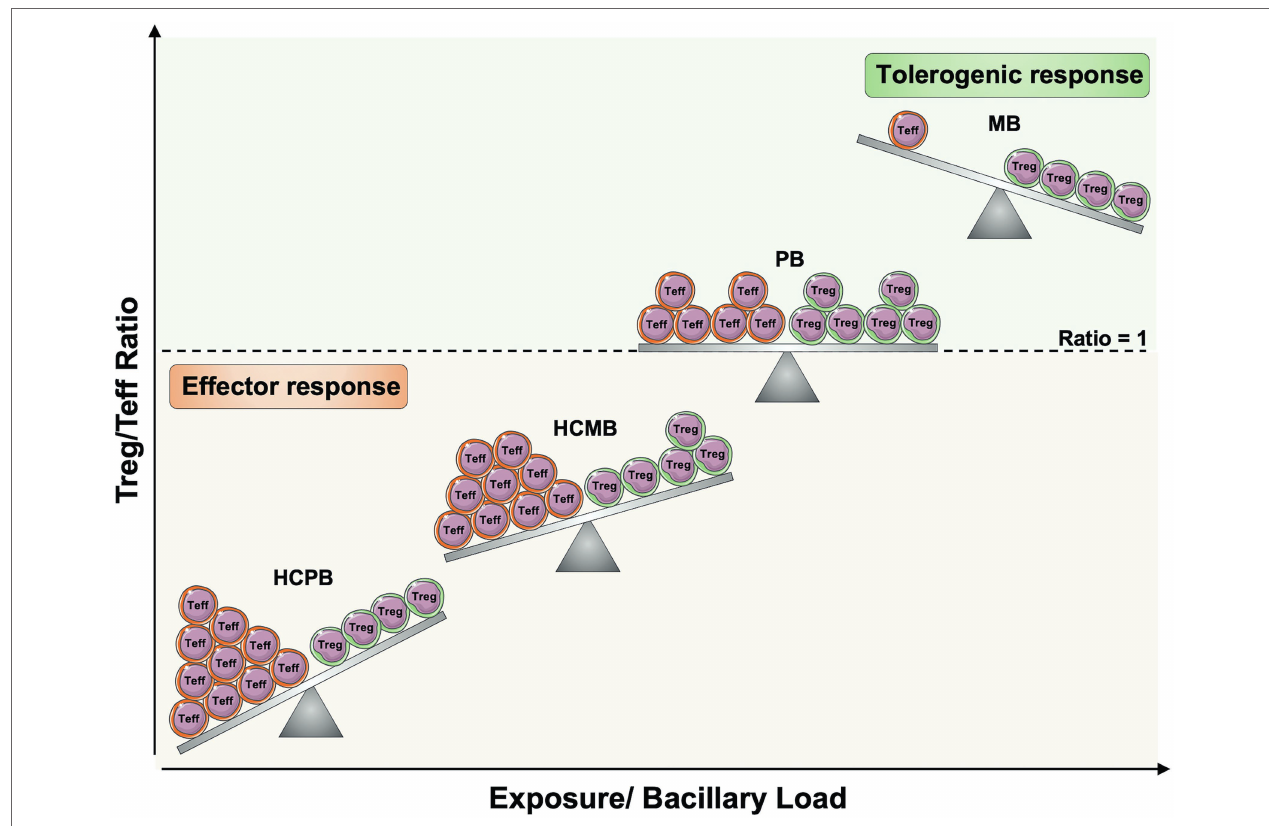
FIGURE 3 | Regulatory and effector T cells balance in leprosy pathogenesis. The increased exposure to Mycobacterium leprae in household contacts of leprosy patients, as well as the increased bacillary load in patients, may alter the balance between antigen-specific regulatory T cells (Treg) and effector T cells (Teff). If the ratio within antigen-specific T cells is toward Teff cells, there will be protective cell-mediated immune responses against M. leprae . However, if the number of Treg cells increases and reaches an equilibrium or exceeds the frequency of Teff cells, effector function against M. leprae will be compromised, and the infection will more likely progress to active disease. Teff, effector T cells; Treg, Regulatory T cells; HCPB, household contacts of paucibacillary patients; HCMB, household contacts of multibacillary patients; PB, paucibacillary patients; MB, multibacillary patients. Created with